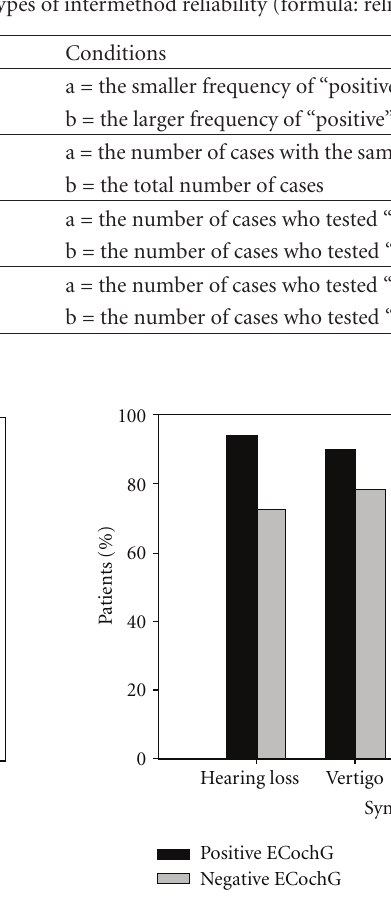
Table 5: Conditions given for the calculation of four types of intermethod reliability (formula: reliability = (a/b) × 100).